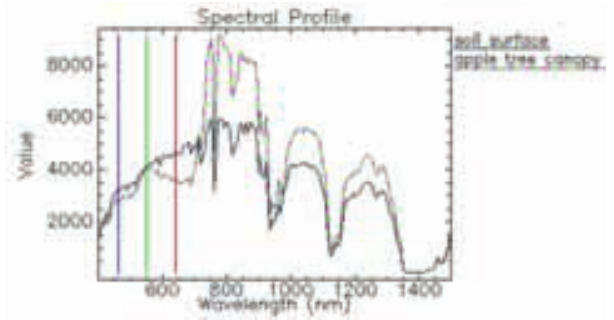
Figure 1. Spectral profile of soil and canopy